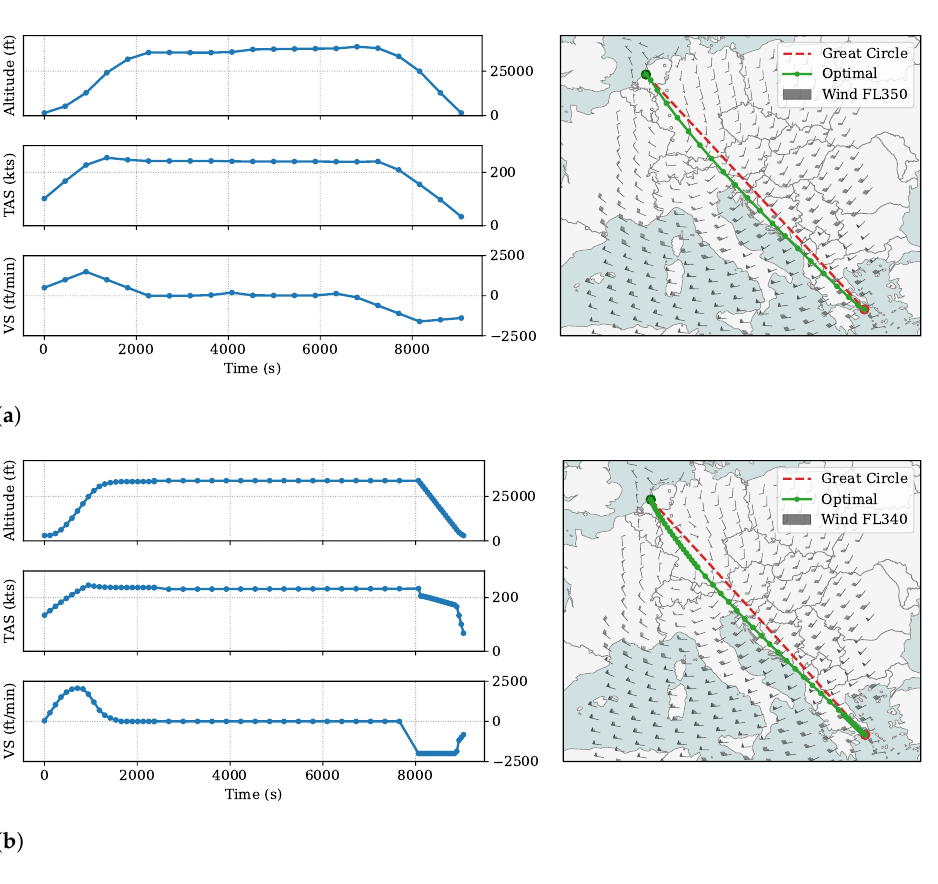
Figure 4. Optimization of complete flight trajectory including climb, cruise, and descent phases. The example flight leaves EHAM, arrives at LGAV, and considers the real 3D wind conditions. Only the wind field at a specific altitude is shown for illustration purposes. ( a ) Complete 4D trajectory and ( b ) Multiphase 4D trajectory, both optimized for fuel consumption.